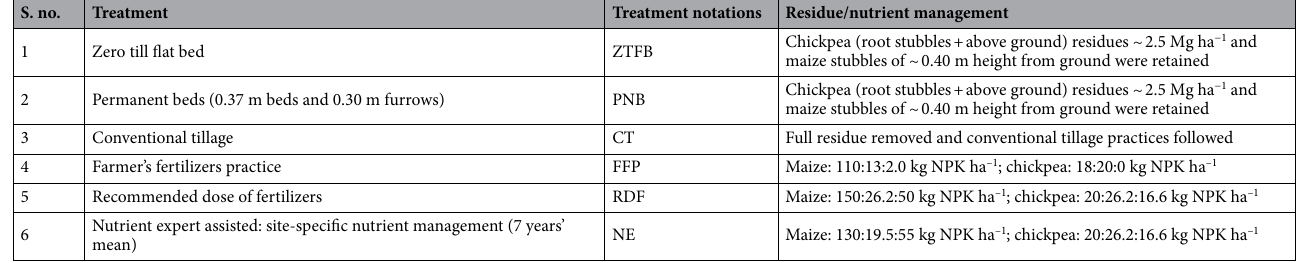
Table 4. Description of the crop establishment practices (CEP) and nutrient management adopted in the maize–chickpea rotation during the 7 years of